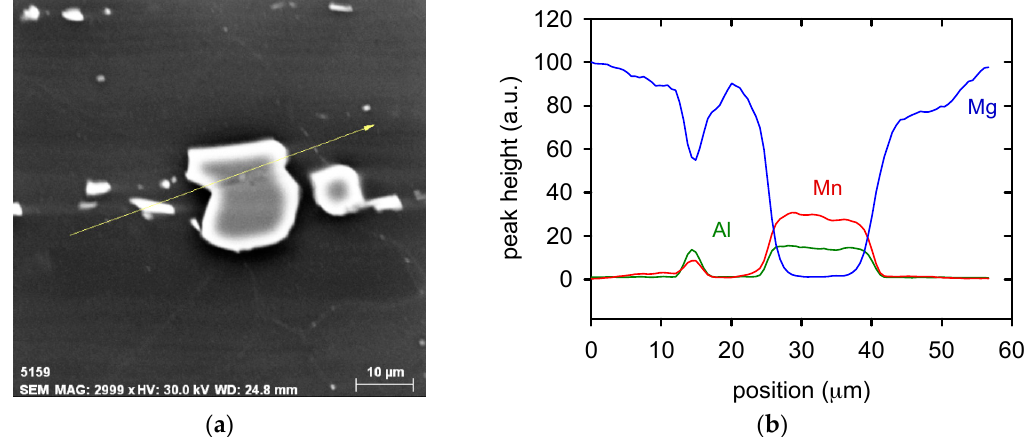
Figure 3. Particle in the microstructure ( a ) and its chemical composition ( b ).